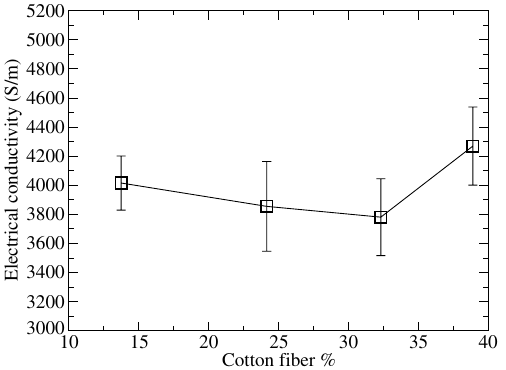
Figure 3. In-plane electrical conductivity of the GDLs with different percentages of cotton fiber. Error bars were determined from three different samples.